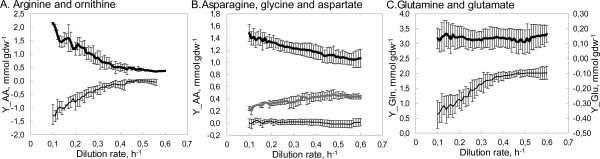
L. lactis dilution rate dependent amino acid consumptions (mmol gdw-1) for (A) arginine (thick line) and ornithine (thin line); (B) asparagine (thick line), glycine (dashed line) and aspartate (thin line); (C) glutamine (thick line) and glutamate (thin line). Negative numbers on chart represent production. Refer to Additional file 2, Figure S2 for consumption yields of all amino acids.